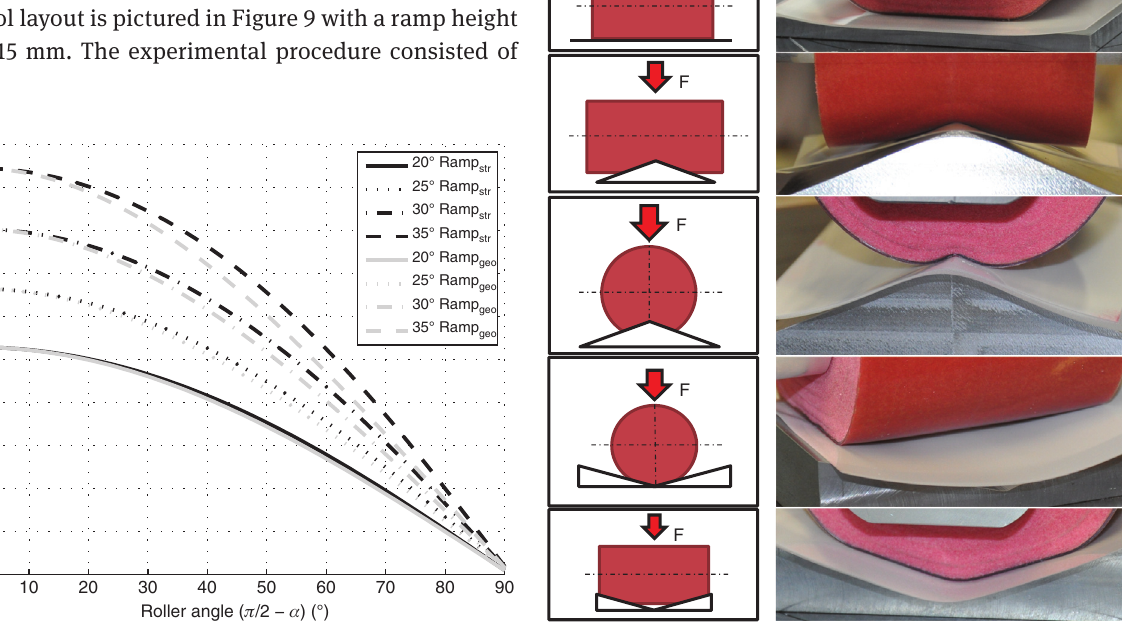
Figure 18 Typical roller deformation for all five test setups. (A) Flat tool, (B) convex tool lateral, (C) convex tool longitudinal, (D) concave tool lateral, (E) concave tool